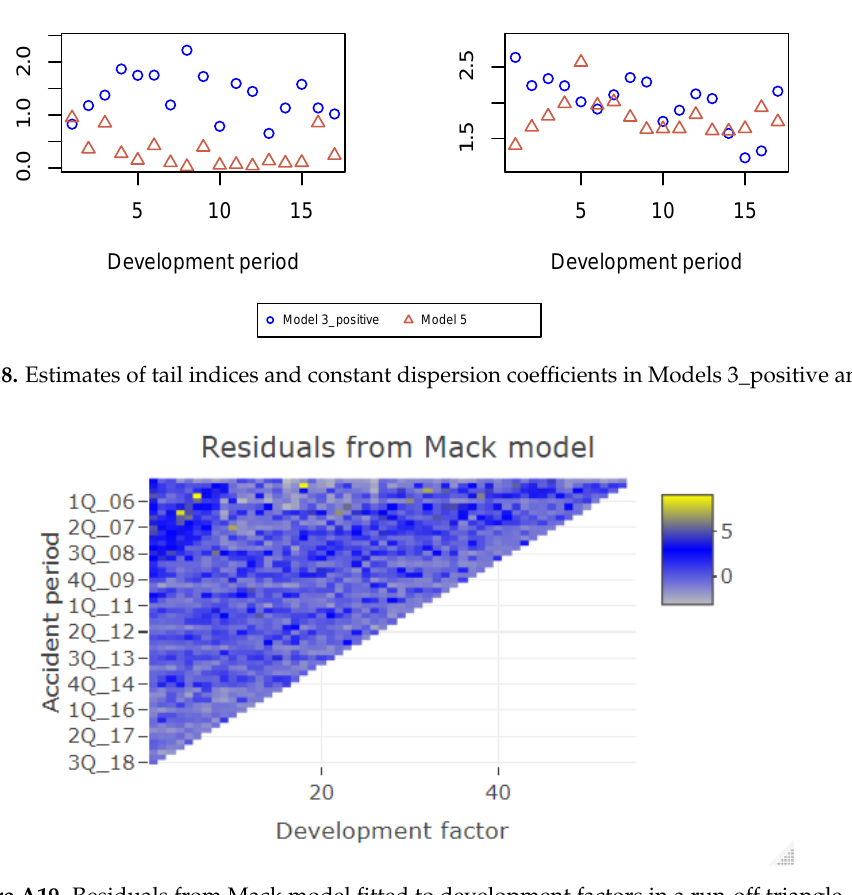
Figure A19. Residuals from Mack model fitted to development factors in a run-off